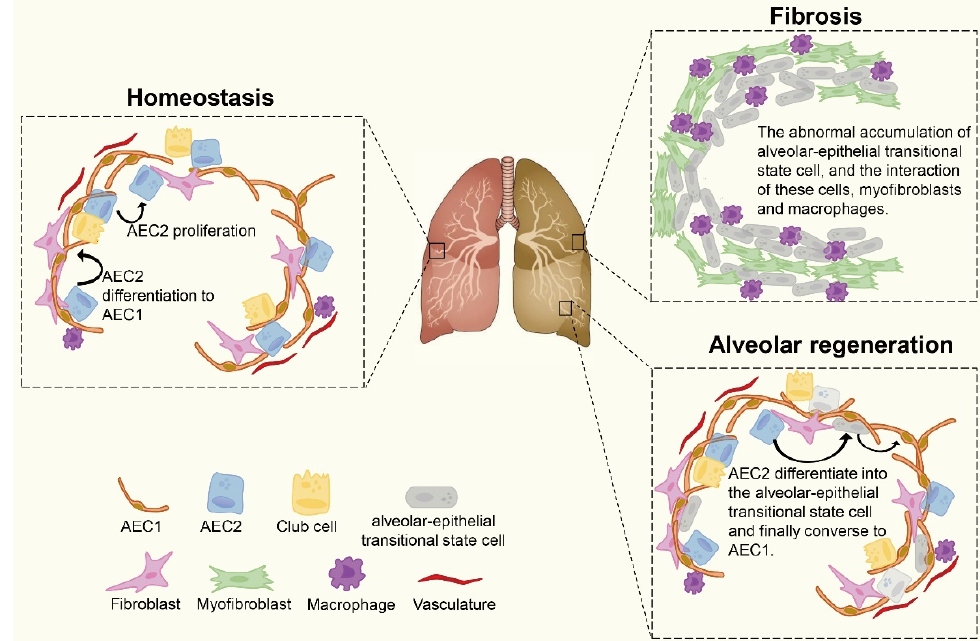
Figure 2. Cellular composition of lung tissue and alveolar regeneration. Alveolar cells are mainly composed of AEC2 and AEC1. In homeostasis, most cells have reduced activity, with low AEC2 cell self-renewal and conversion to AEC1 cells. After lung injury, AEC2 increase speed of proliferation and differentiation in order to recover the alveolar barriers. In fibrosis, there is an increase in tran- sitional state cells, accompanied by an increase in myofibroblasts. In addition, these transitional state cells demonstrate the largest communication network with macrophages and fibroblasts. Dur- ing alveolar generation, AEC2 and the transitional states convert into AEC1 successfully to recon- struct the epithelial barrier and prevent fibrosis.